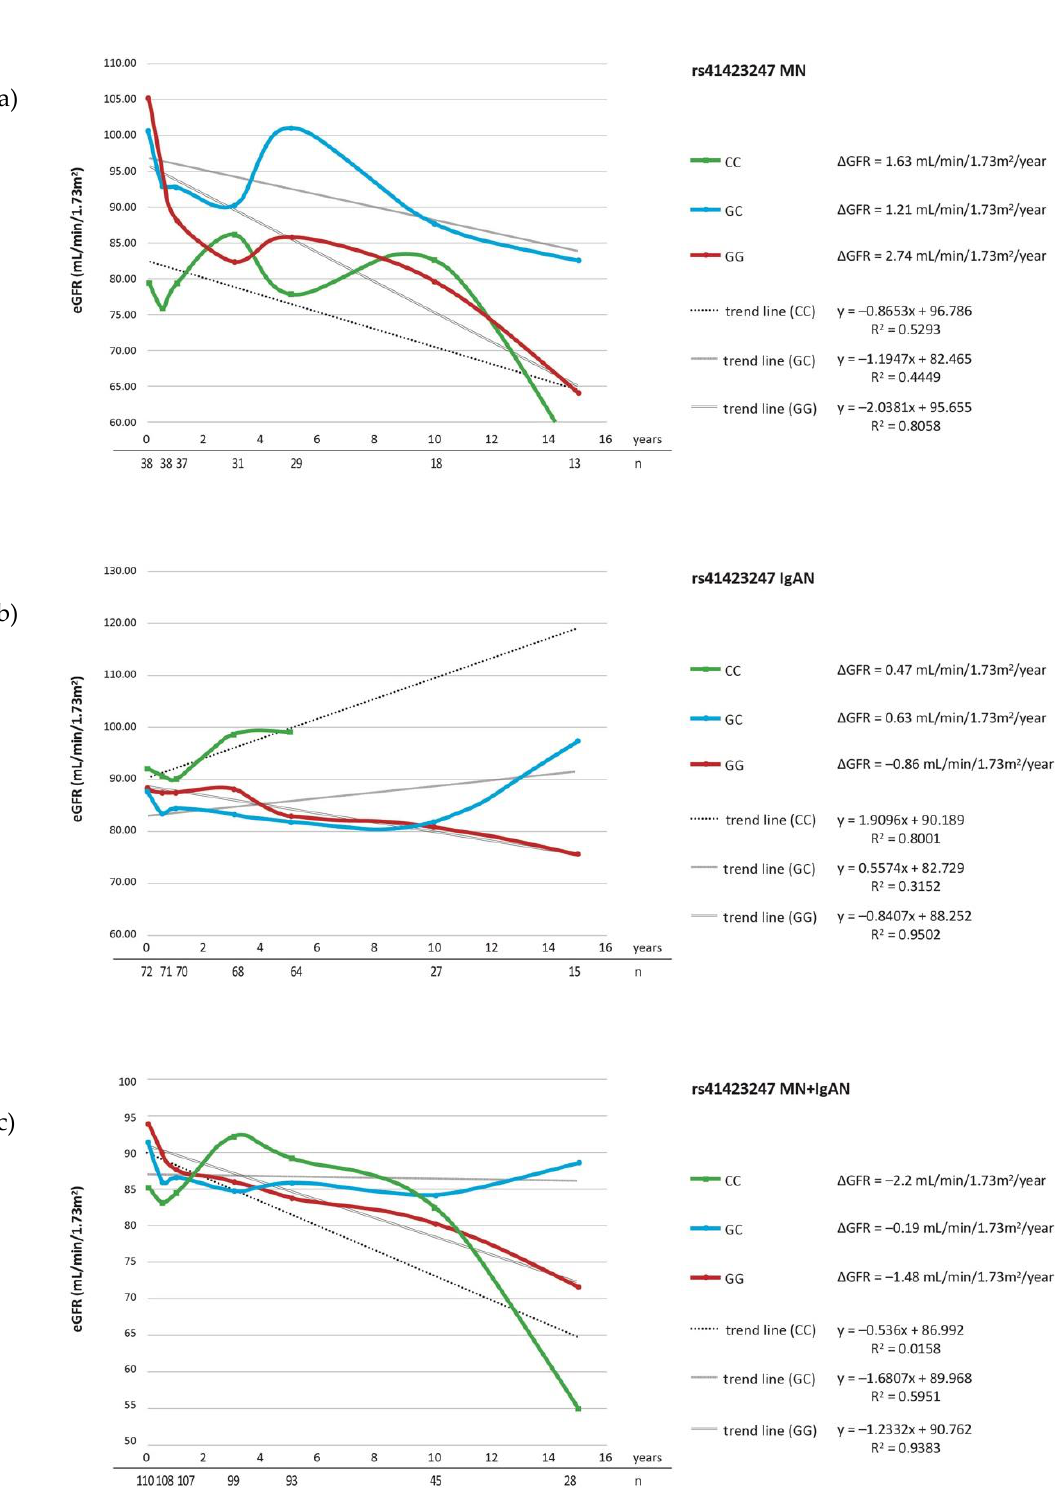
Figure 2. ΔeGFR for rs41423247 genotypes during follow-up period in ( a ) MN patients; ( b ) IgAN patients; ( c ) MN + IgAN patients. Number of patients are expressed as ( n ).